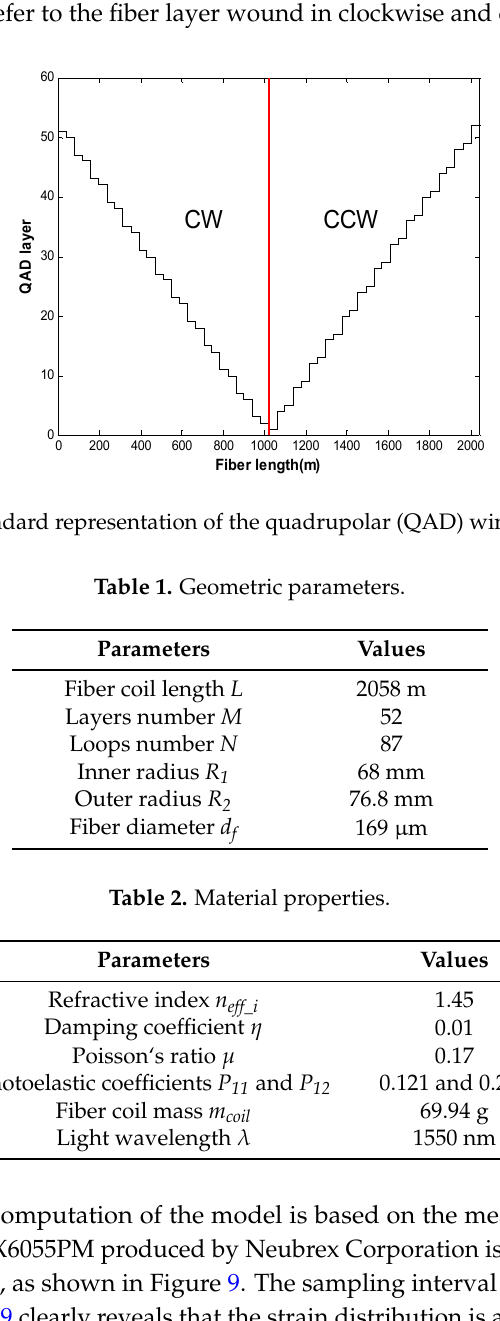
Figure 9. Strain distribution of the QAD fiber coil.